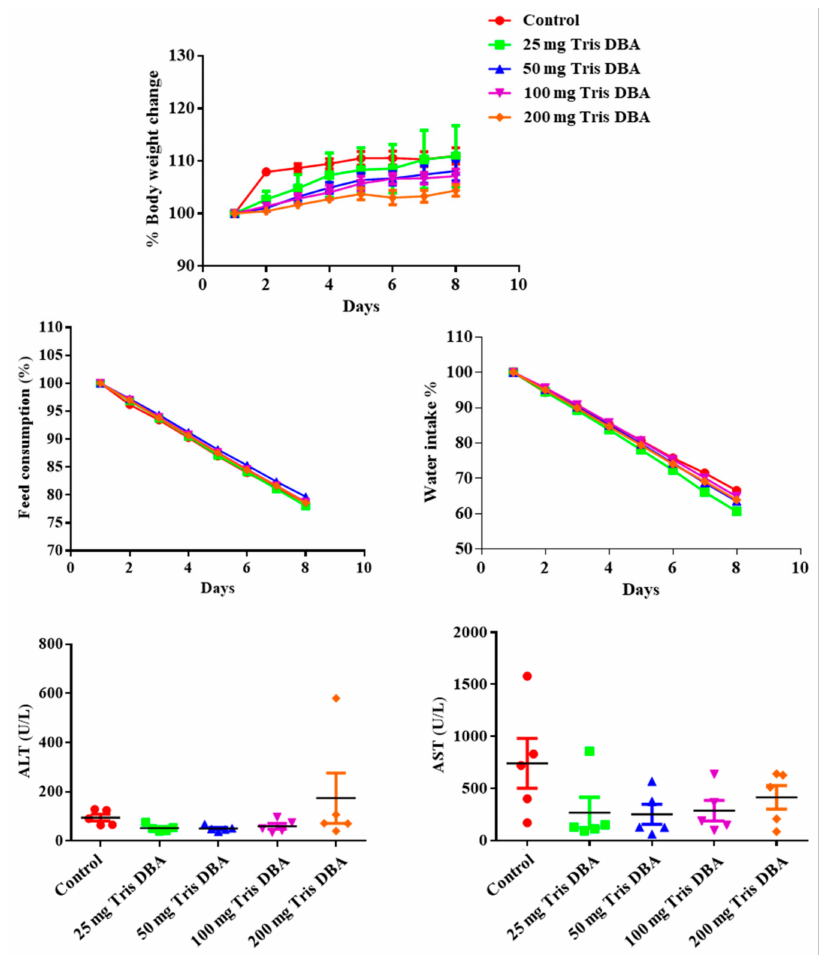
Figure 6. Tris DBA exhibited no significant toxicity in vivo. The nude mice ( n = 5) per group were treated with one single dose of Tris DBA (25, or 50, or 100, or 200 mg/kg) and 0.1% DMSO control intraperitoneally and effect of Tris DBA on body weight, feed consumption, water intake, and various biochemical parameters were